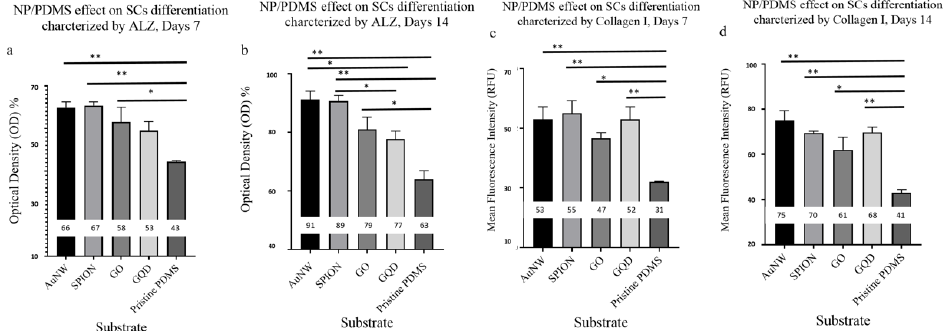
Figure 5. Normalized optical density measurement of calcium deposition of hAMSCs differentiated to osteogenic lineage on nanoparticle (NP) / PDMS substrate ( a , b ). Mean fluorescence intensity to osteogenic lineage on nanoparticle (NP)/PDMS substrate ( a and b ). Mean fluorescence intensity measurement of immunofluorescence staining of Coll I of hAMSCs di ff erentiated to osteogenic measurement of immunofluorescence staining of Coll I of hAMSCs differentiated to osteogenic lineage on NP/PDMS substrates ( c and d ). lineage on NP / PDMS substrates ( c , d